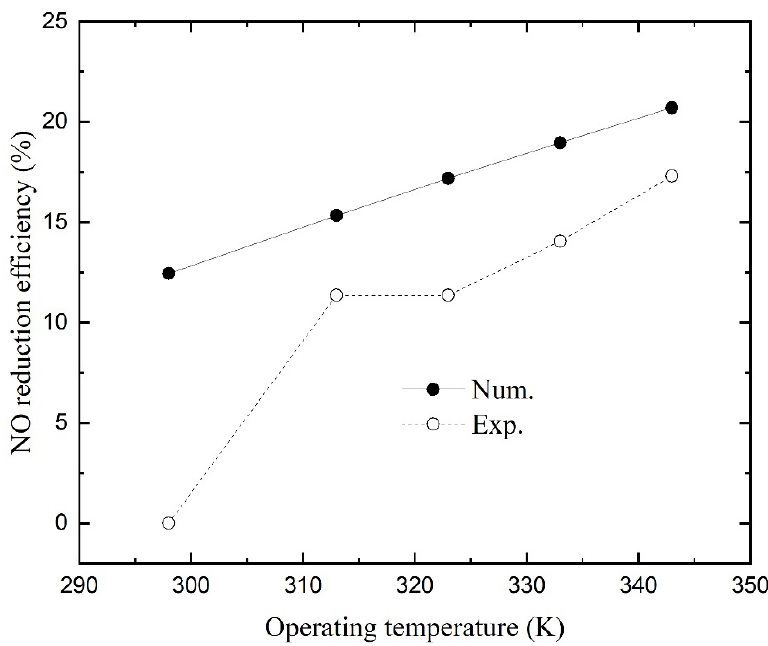
Figure 7. NO reduction efficiency as a function of operating temperature.